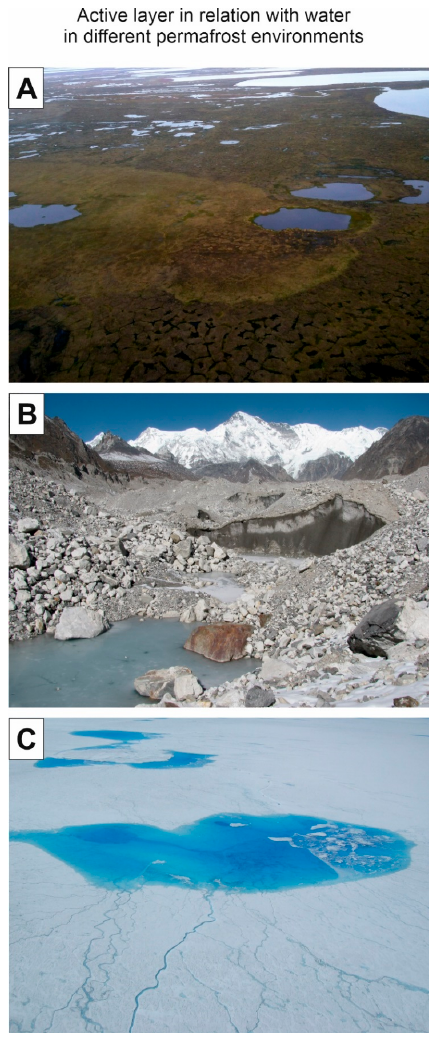
Figure 2. Differentiation of the active layer depending on the environment. A —traditional periglacial environment of patterned ground near Ivotuk, Alaska, covered by numerous melt ponds (July 2013); photo credit: Jennifer Watts, (https://www.uspermafrost.org/); B —Debris covered glacier/active rock glacier in mountainous periglacial areas: Ngozumpa Glacier, Everest region, Nepal. The rough topography of the Ngozumpa Glacier is shown covered by melt ponds, illustrating the thermokarst processes. (November 2009) photo credit: Kimberly Casey, courtesy: Andreas Kääb, (http://folk.uio.no/kaeaeb). C —in glacial environment: supraglacial lakes and melt water rivers on the Greenland Ice Sheet, June 2006, photo credit: Ian Joughin / University of Washington Polar Science Center, Courtesy: National Science Foundation (https://www.nasa.gov/).